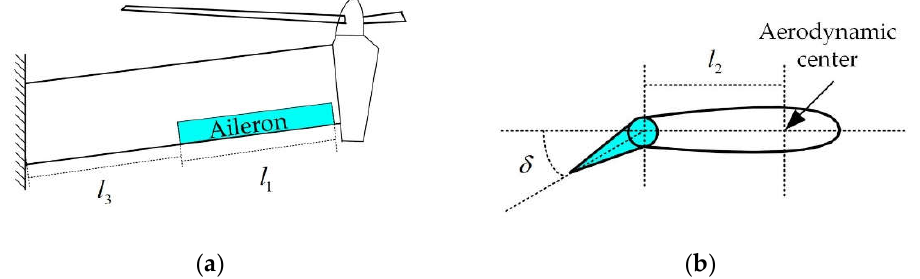
Figure 9. Schematic of the simulation model: ( a ) Aileron mounted on the wing; ( b ) Cross section of wing with aileron.